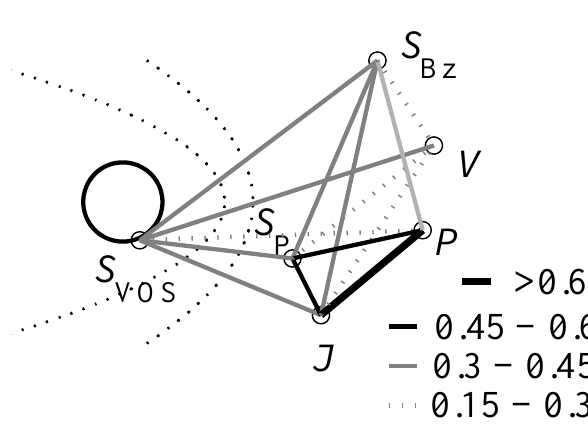
Fig. 12. Summary sketch of averaged correlations between all the parameters studied. The power spectral density at VOS and in the SW are taken in the low-frequency band